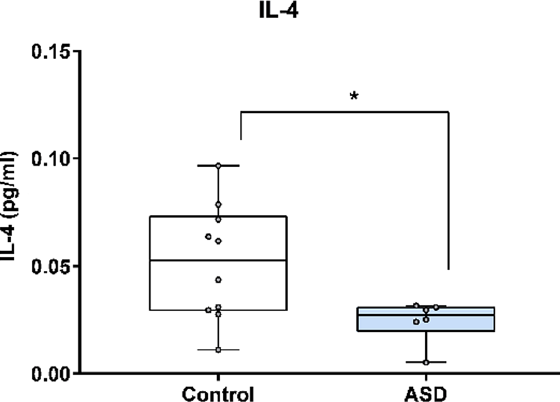
Figure 4. IL-4 concentration in ASD cases versus matched controls.